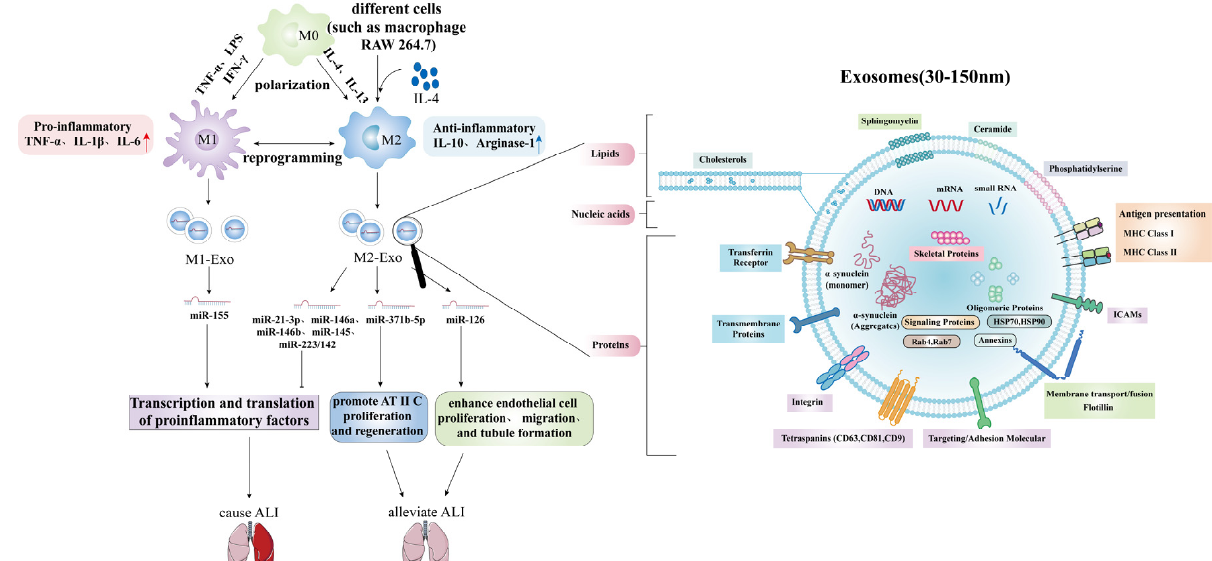
Figure 4. The role of exosomal microRNAs in LPS-induced ALI/ARDS. In addition, Quan et al. [131] found that exosomes derived from alveolar progenitor Type II cell (AT II C) multipotent stem cells carrying miR-371b-5p can improve the survival probability and even promote the proliferation of AT II C and promote the regeneration of damaged alveolar epithelium. Furthermore, endothelial progenitor cell-derived exosomes are enriched in miR-126, which can target and downregulate Sprouty-related EVH1 domain- containing protein 1 (SPRED1) and activate rapidly accelerated fibrosarcoma/extracellular signal regulated kinase (RAF/ERK) signaling pathway, improve endothelial cell function, enhance endothelial cell proliferation, migration, and tubule formation, and improve LPS- of various proinflammatory factors by M0-Exosome vesicles (EVs) in bronchoalveolar